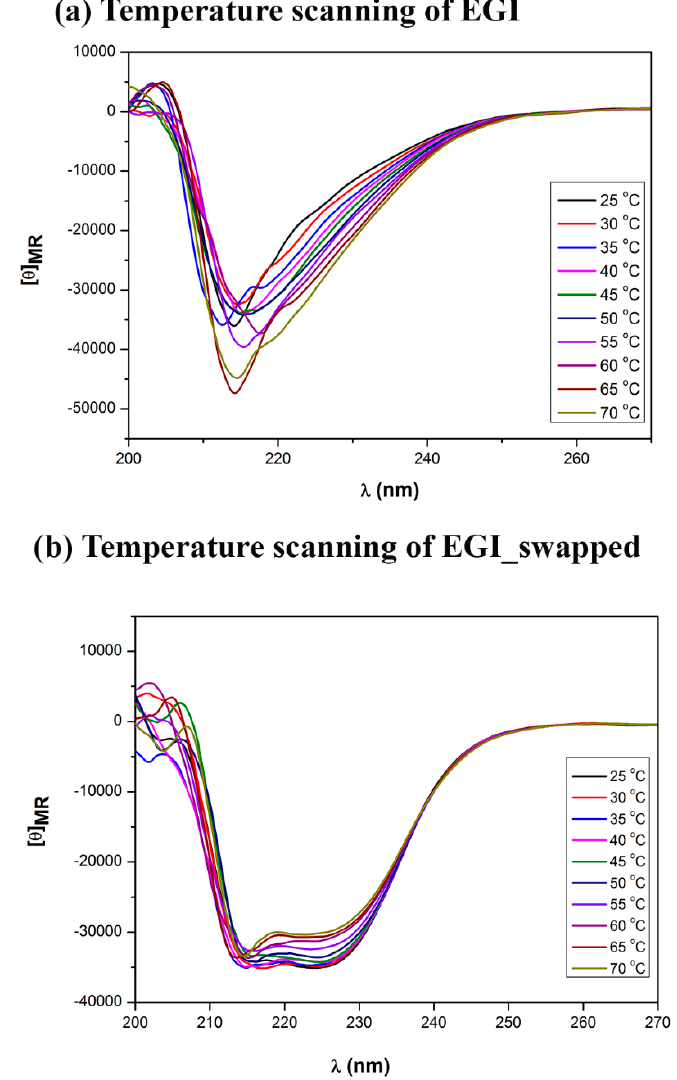
Figure 5. Temperature scanning of EGI ( a ) and EGI_swapped enzymes ( b ). Through Circular Dichroism, the change in the structure of endoglucanase I enzyme upon domain swapping has been